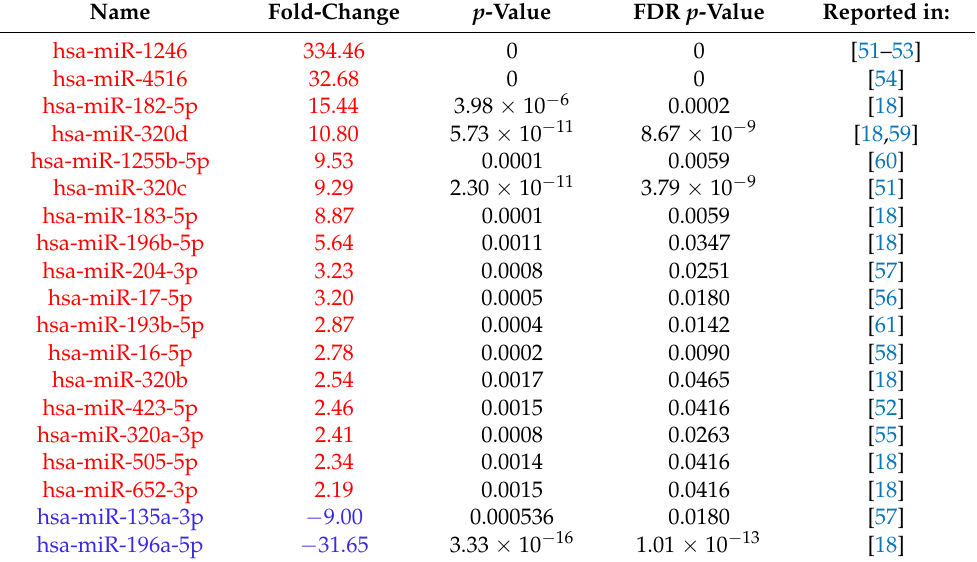
Table 1. Differential (>2-fold change, FDR p < 0.05) expression of miRNAs in human stroke brain tissue—significantly dysregulated stroke-related miRNAs. Red—upregulated and blue— downregulated miRNAs. Name Fold-Change p -Value FDR p -Value Reported